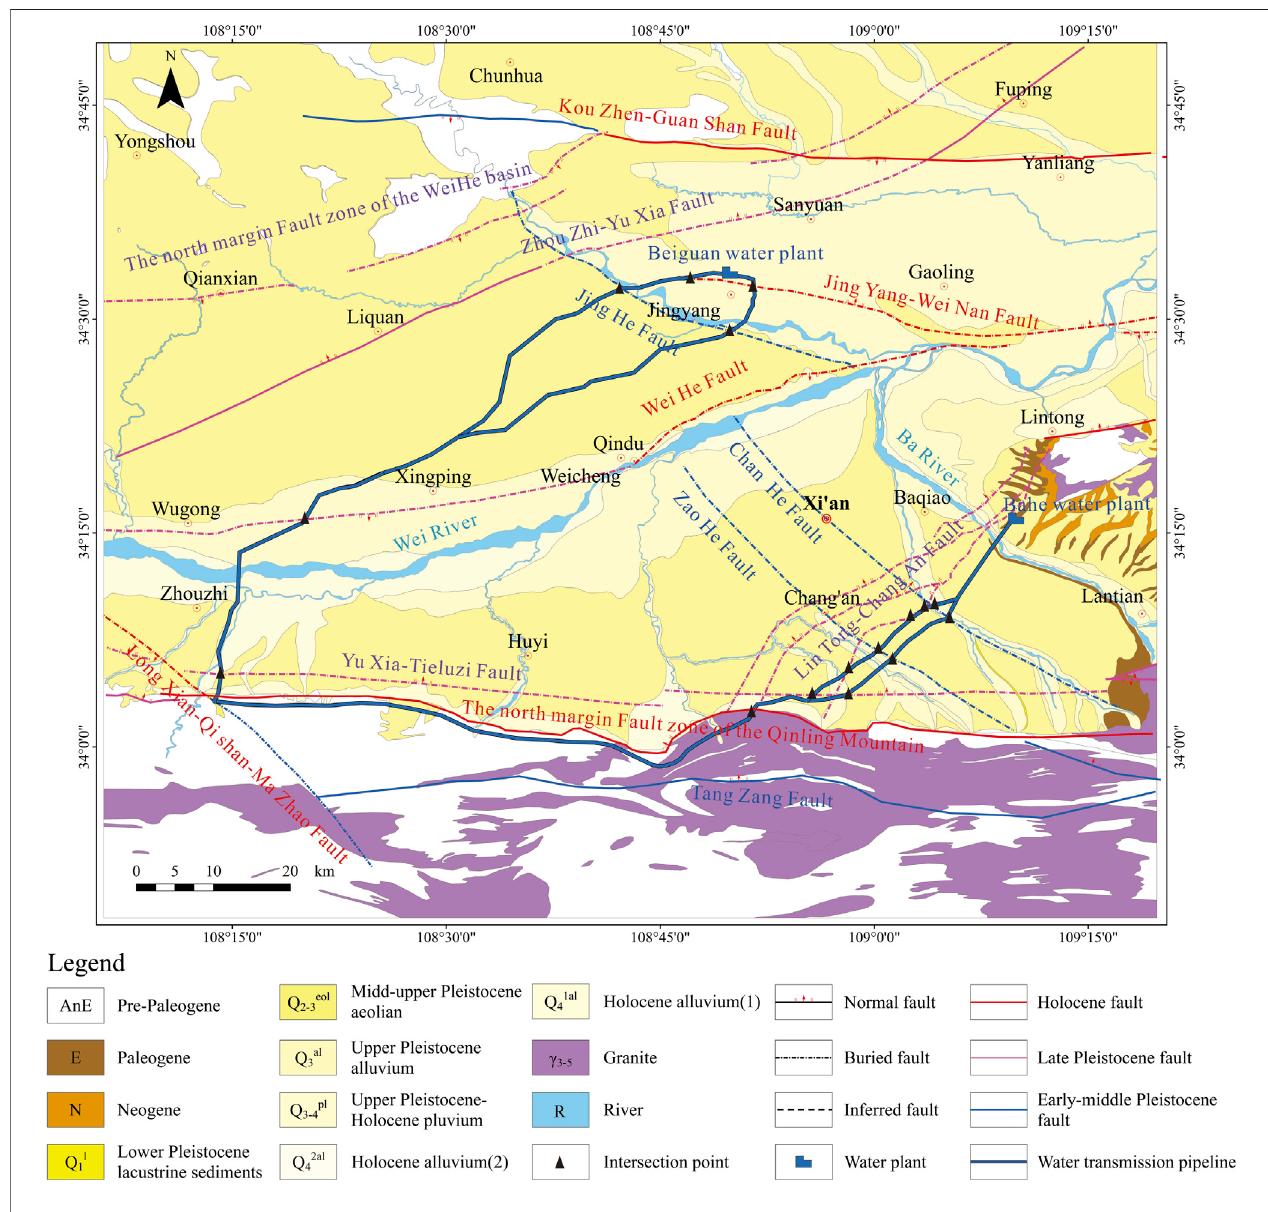
FIGURE 1 | Geological conditions of the project (Deng,